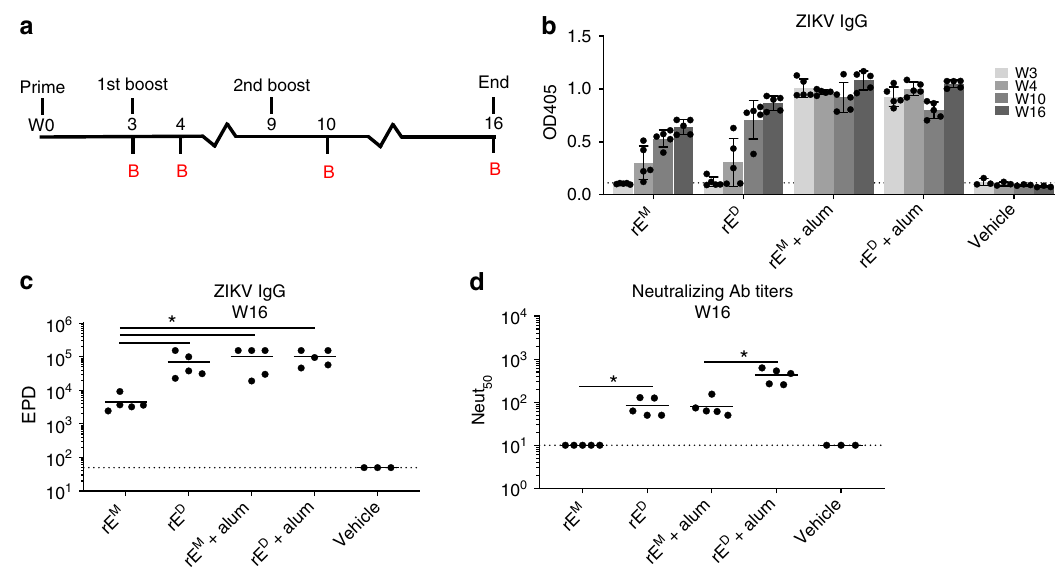
Fig. 2 ZIKV rE D induces neutralizing antibody responses. a Mice were primed with 5 µ g of ZIKV rE M or rE D ( + / − alum) and boosted with similar doses at weeks 3 and 9. Mice were bled ( b ) at indicated time points ( n = 5 for rE M , rE D , rE M + alum, and rE D + alum, and n = 3 for vehicle control). b ZIKV-speci fi c single point dilution (1:50) IgG titers were determined by virus capture ELISA. c ZIKV-speci fi c endpoint dilution (EPD) titers were determined at week 16 by virus capture ELISA; EPD is the serum dilution at which detection signal equals background levels. d ZIKV-neutralizing activity at week 16 was determined on Vero cells and expressed as the serum dilution at which 50% of the virus was neutralized (Neut 50 ). Statistical differences were determined by one-way ANOVA followed by a Tukey ’ s test (* p < 0.05). Data points represent individual mice. Error bars represent standard deviation. Source data are provided